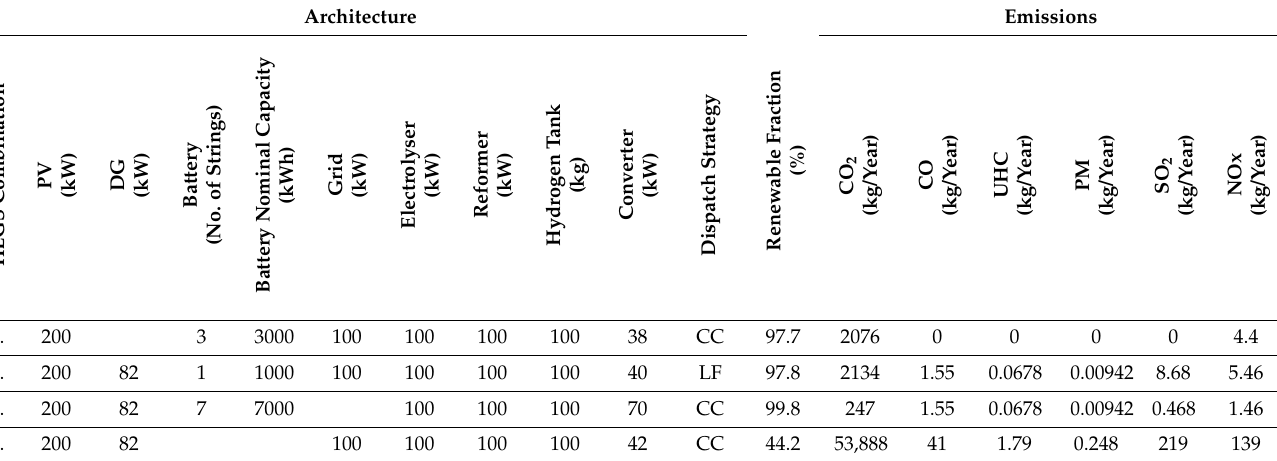
Table 9. Summary of pollutant emissions for proposed HEGS.